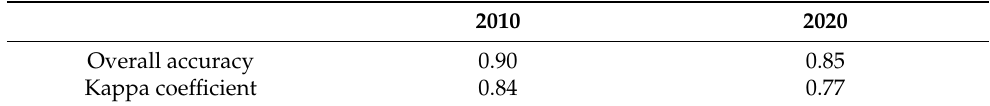
Table 6. The accuracy assessment of PLUS